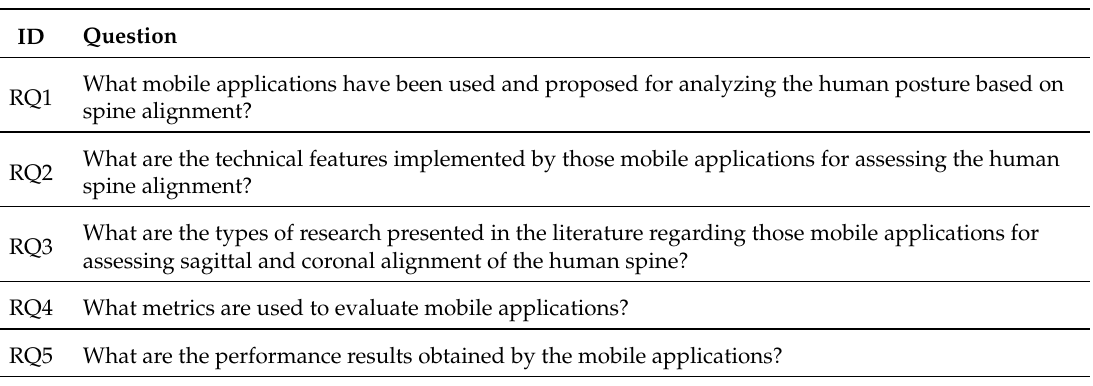
Table 4. Research questions.